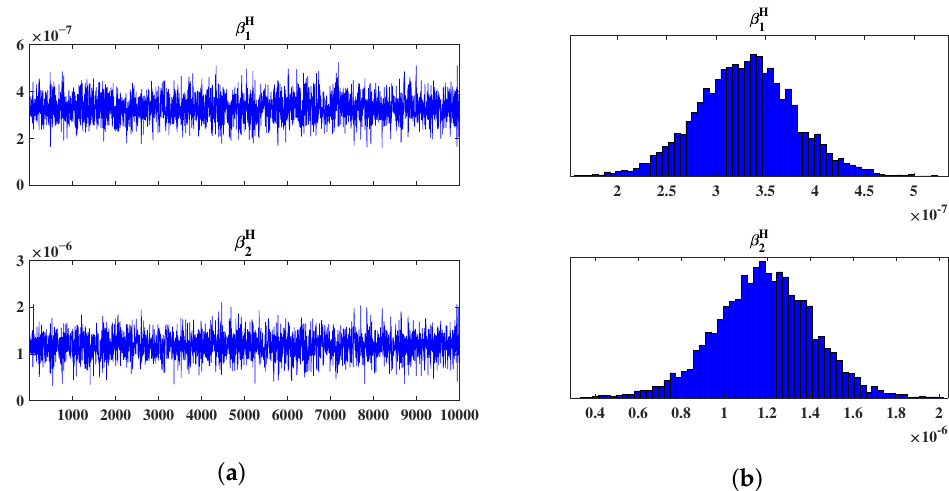
Figure 3. ( a ) Simulation results for parameter β H realizations. ( b ) The histogram of parameter β H